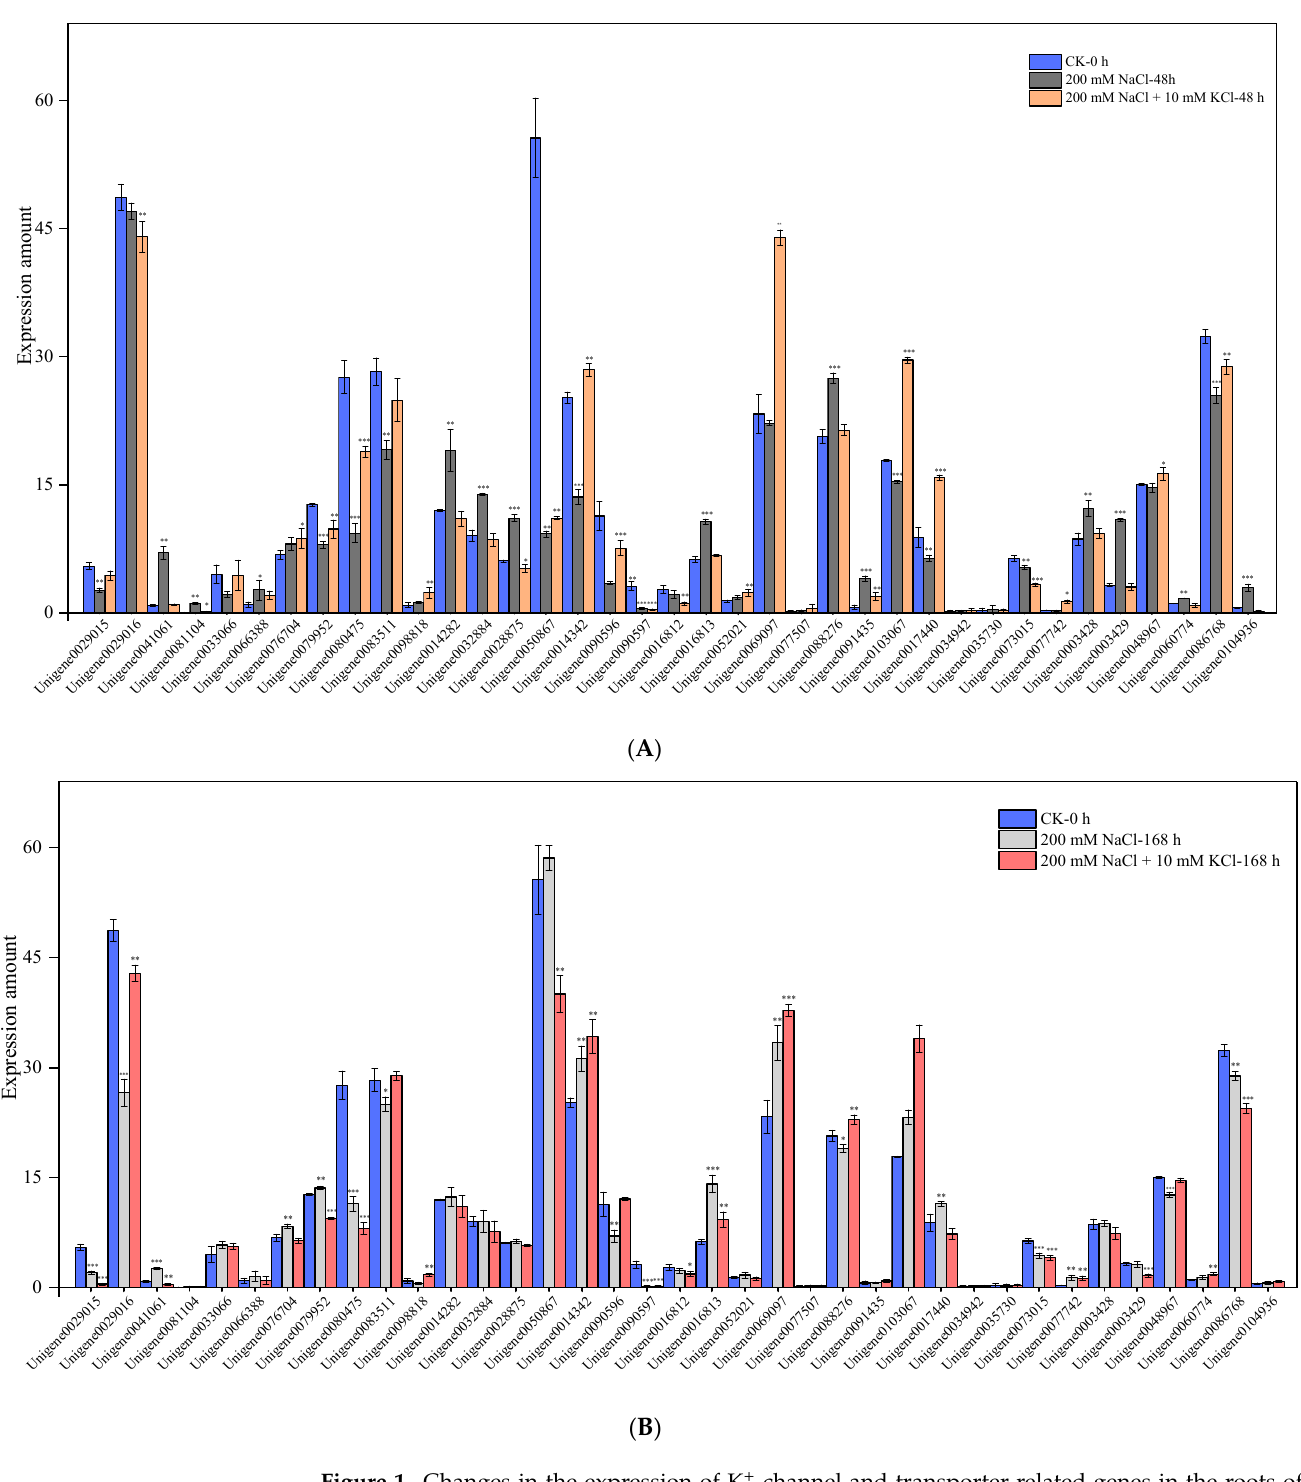
Figure 1. Changes in the expression of K + channel and transporter-related genes in the roots of T . ramosissima with exogenous potassium application under NaCl stress (changes in expression levels of 37 K + channel and transporter-related genes. Note: ( A ) represents the changes in the expression levels of 37 expressed genes in T . ramosissima under NaCl stress for 48 h; ( B ) represents the changes in the expression levels of 37 expressed genes in T . ramosissima under NaCl stress for 168 h; 0.01 < p < 0.05 is marked as *; 0.001 < p < 0.01 is marked as **; p ≤ 0.001 is marked as ***).